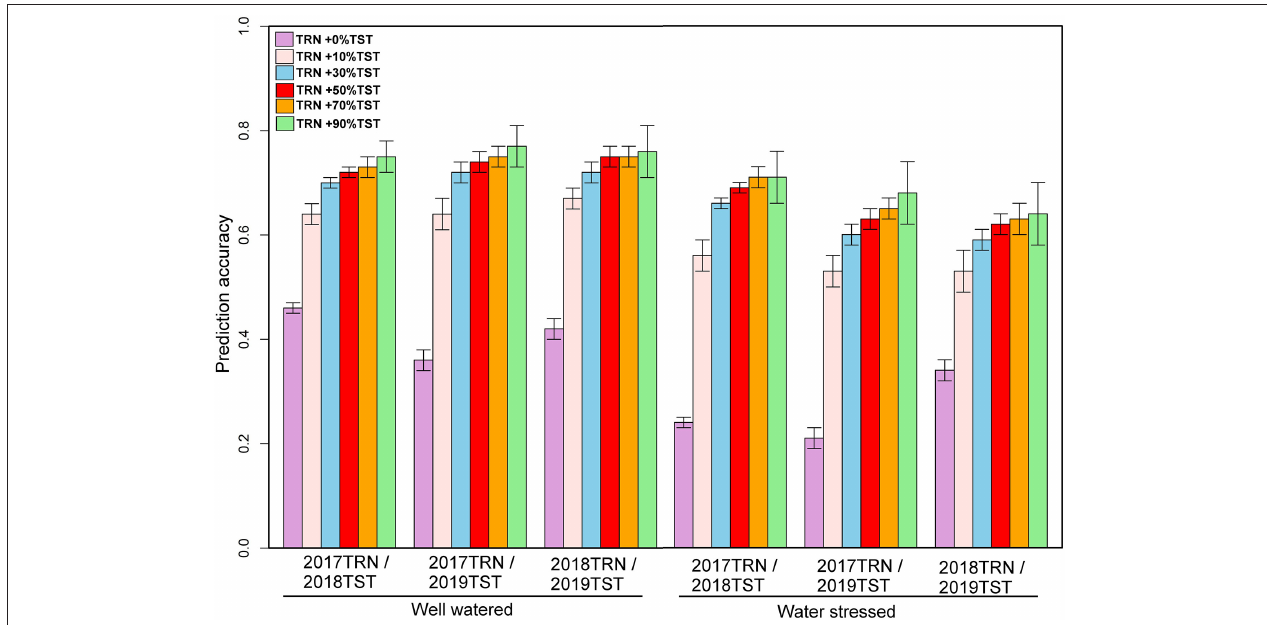
FIGURE 3 | Prediction accuracies for anthesis date estimated from independent validation schemes using 1-year data to predict another year’s data and converting 10, 30, 50, 70, and 90% of the data from the testing population to the training population under optimum and managed drought conditions.